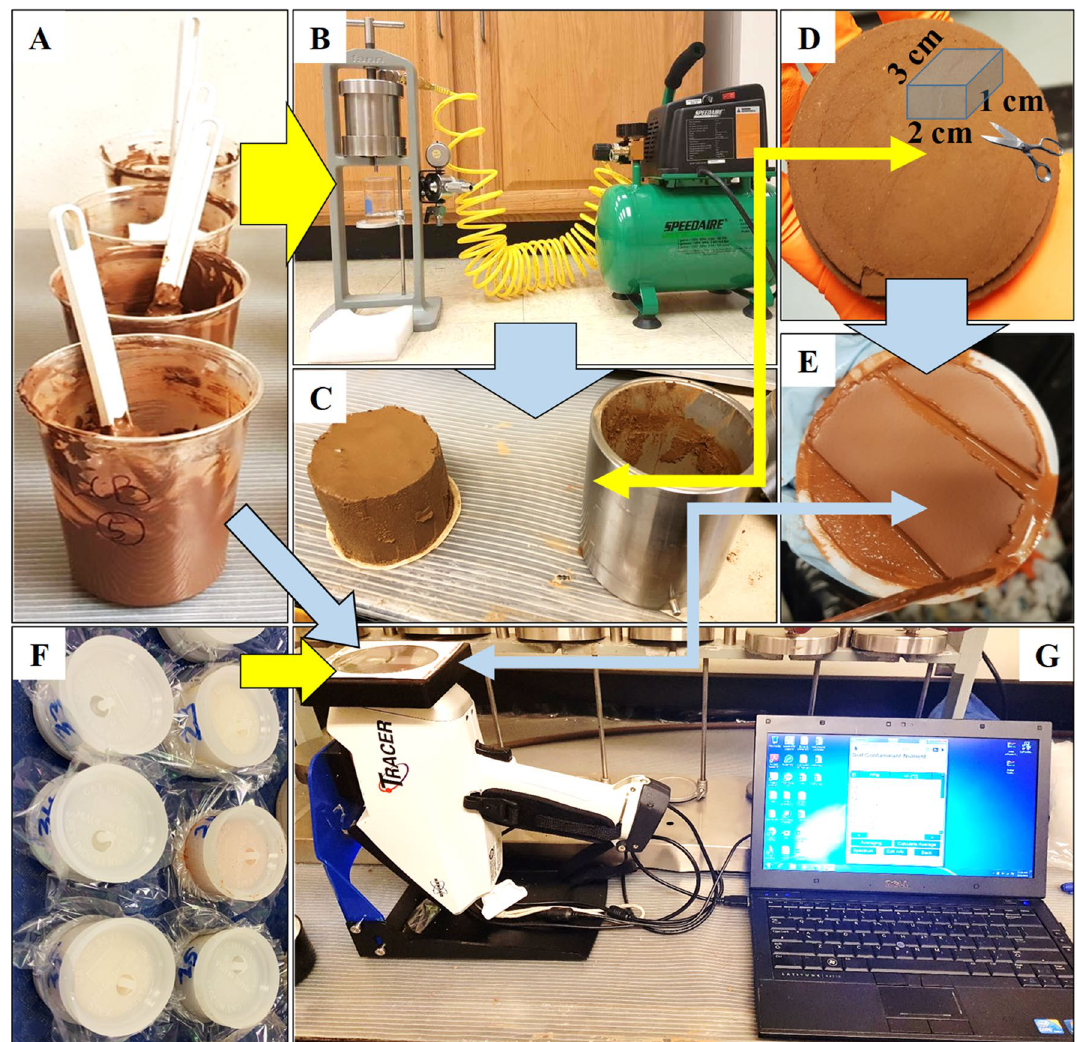
Figure 1. Flow diagram of metal detection in horizontal directional drilling (HDD) mud using a potable x-ray fluorescence spectrometer (pXRF). Saturated paste ( A ) of the soils or HDD residues is transferred into a metal cylinder mounted on a filter press and the excess water is removed by pressure using compressed air ( B ); then the moist sample is taken out of the cylinder ( C ) and properly cut ( D ) to fit in the sample holder and placed on the sensing window of the pXRF unit. The wet sample at the saturated paste (A) or after the removal of the excess water ( E ) and the same samples oven-dried at 105 °C and ground ( F ) were subjected to pXRF measurements ( G